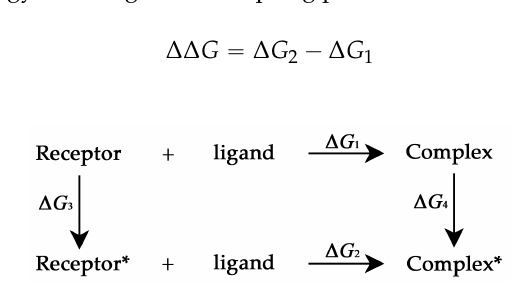
involved in this residue. It should be pointed out that only the first 30 slowest normal modes of the